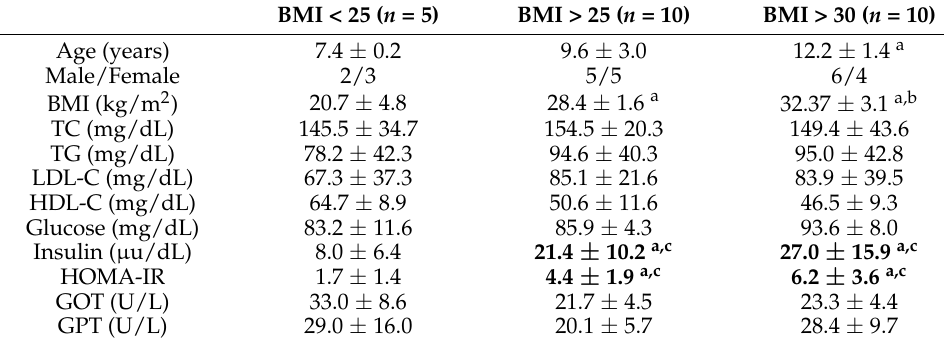
Table 1. Characteristics (means ± SD) of the 25 children